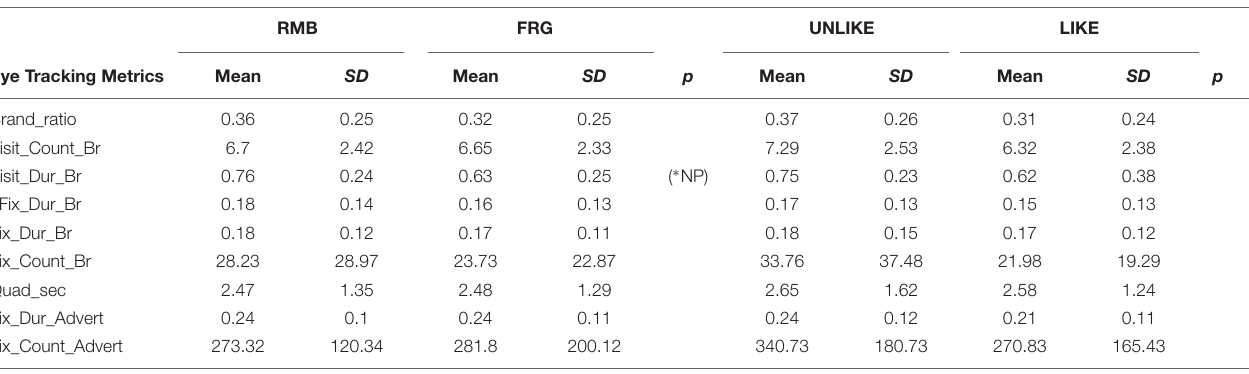
TABLE 3 | Mean comparisons of ET metrics.